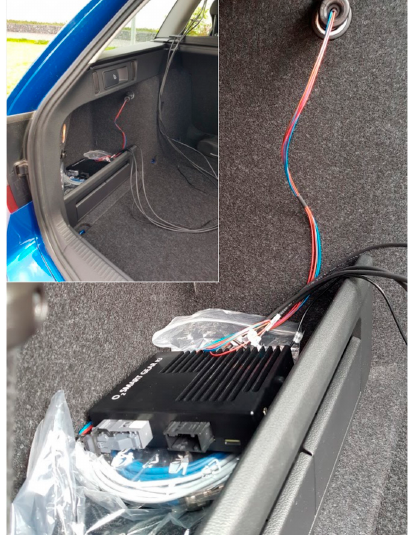
Figure 3. Hybrid C ‐ ITS OBU Smart GEAR used during the test. Figure 3. Hybrid C-ITS OBU Smart GEAR used during the